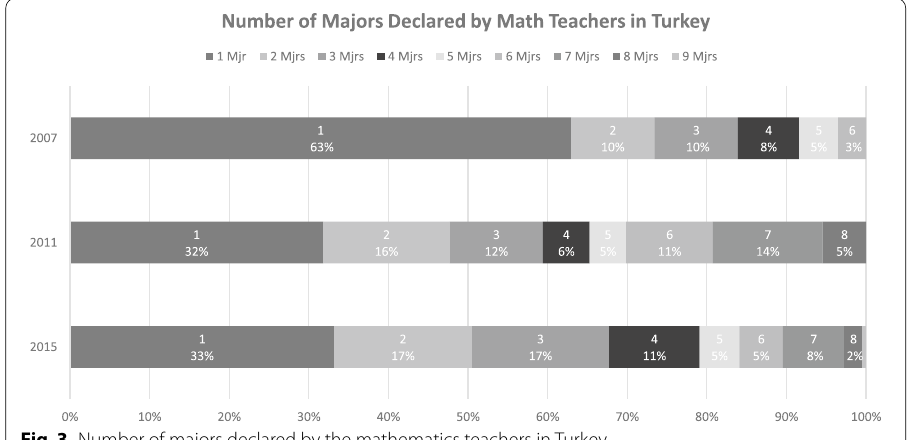
Fig. 3 Number of majors declared by the mathematics teachers in